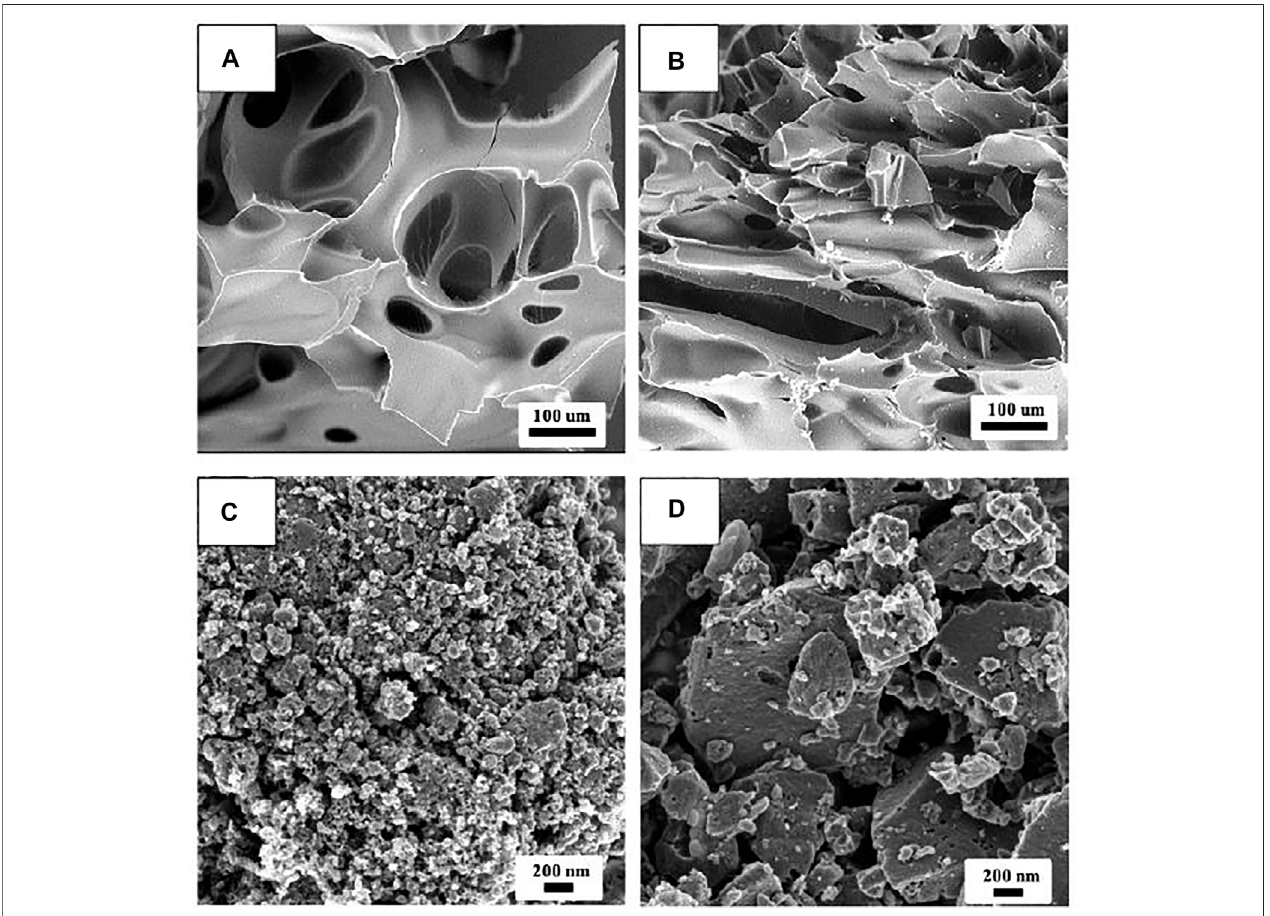
FIGURE 5 | SEM images of different lignin precursors: (A) YP-py and (B) SG-py and SEM images of different ball-milled AC samples: (C) YP-AC and (D) SG-AC.